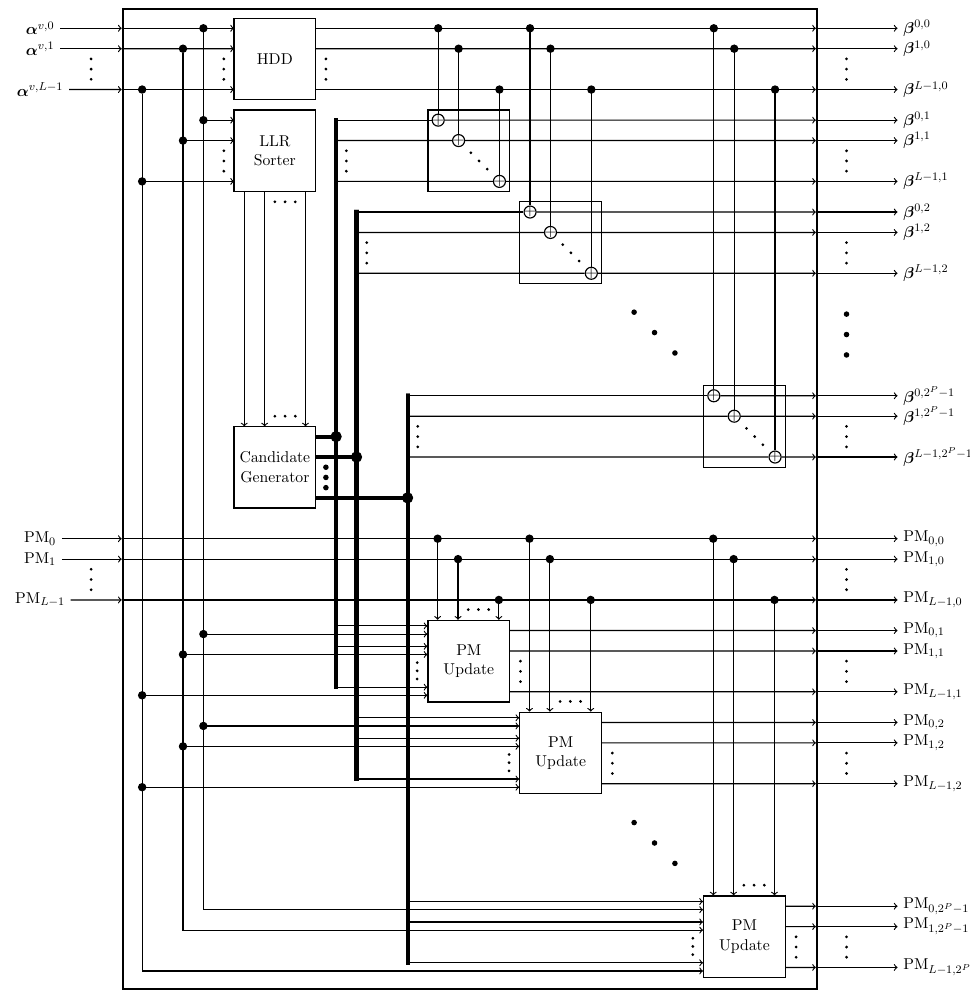
Figure 2. Parallel Rate-1 node